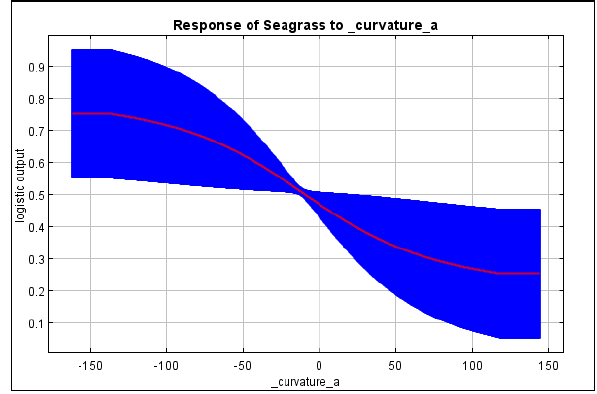
Figure 11. Response curves of curvature for the seagrass habitat suitability